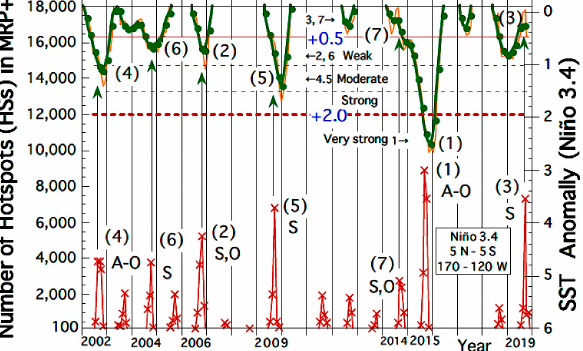
Figure 3. Monthly number of hotspots (HSs) and Niño 3.4. See captions in Figure 2. SST: sea-surface